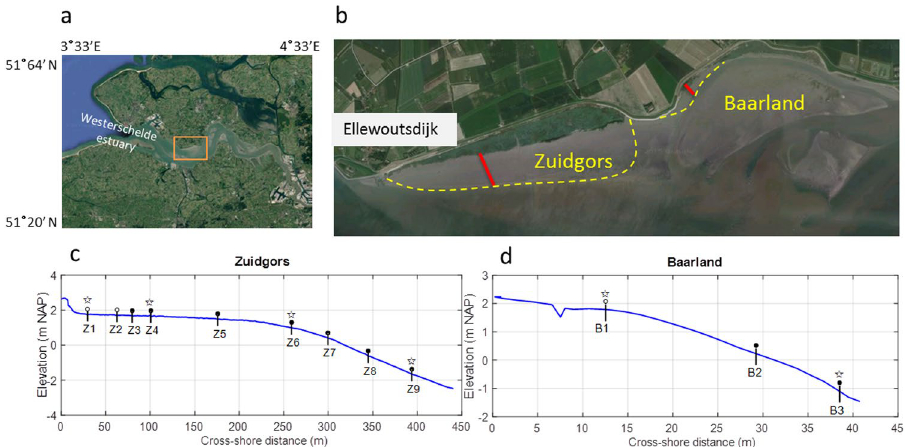
Figure 1. Study site at the northern bank of the Westerschelde estuary, south-west of the Netherlands (plane a ). Two tidal flats (Zuidgors and Baarland) near the town Ellewoutsdijk were monitored (plane b ). The seaward boarder of these two tidal flats are indicated by yellow dash line. The Zuidgors site is directly exposed to waves, whereas the Baarland site is sheltered from waves by a seaward shoal. 9 stations (Z1-Z9) were deployed at the Zuidgors site, and 3 stations (B1-B3) were deployed at the Baarland site (plane c and d ). Elevation is relative to NAP (Normal Amsterdam Peil). An SED-sensor is deployed at each station. Pressure sensors for wave measurement and ADCP for velocity measurement are indicated by filled circles and open stars, respectively. Stations with open cycles do not have pressure sensors installed. Images in panel a and b are from Map data ©2017